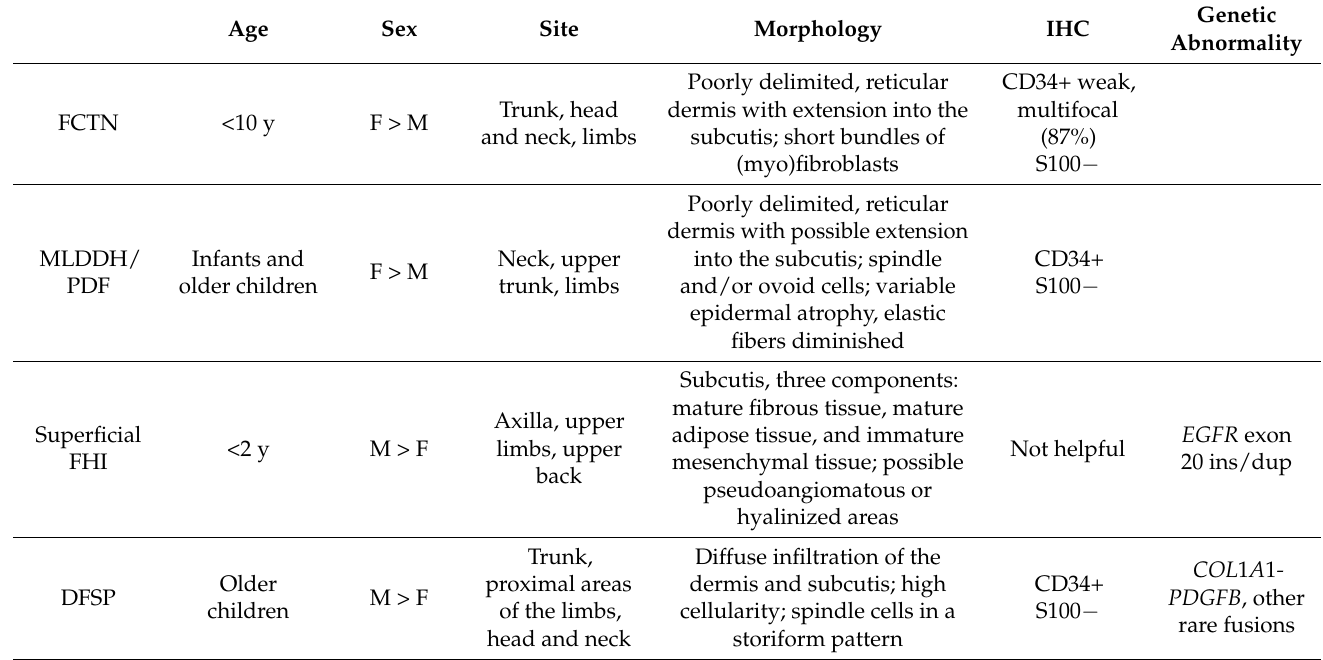
FCTN: fibroblastic connective tissue nevus; MLDDH: medallion-like dermal dendrocyte hamartoma; PDF: plaque-like CD34-positive dermal fibroma; FHI: fibrous hamartoma of infancy; DFSP: dermatofibrosarcoma